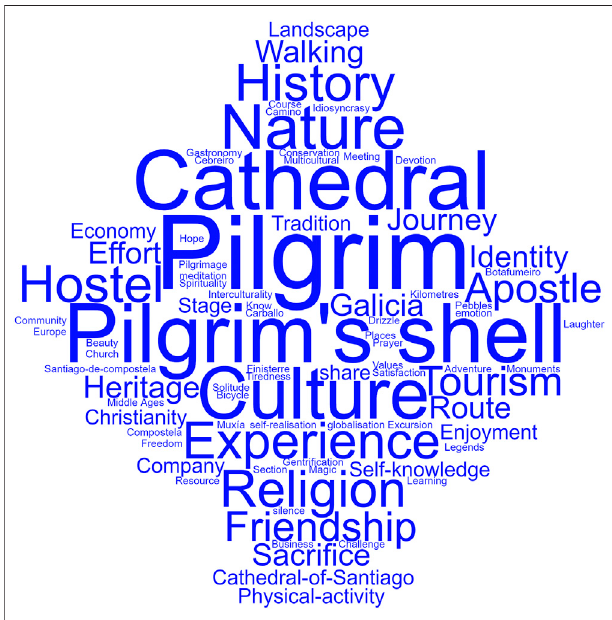
FIGURE 1 | Pre-test: Words on the way of St. James.